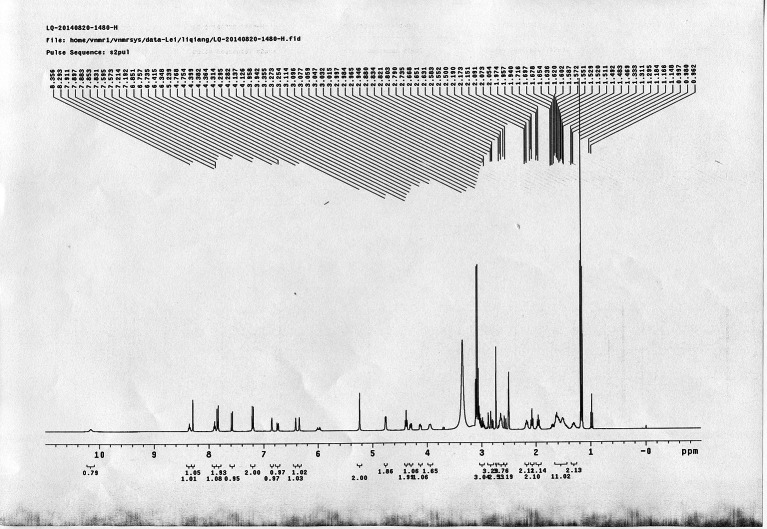
1H NMR spectra of bAL 1.